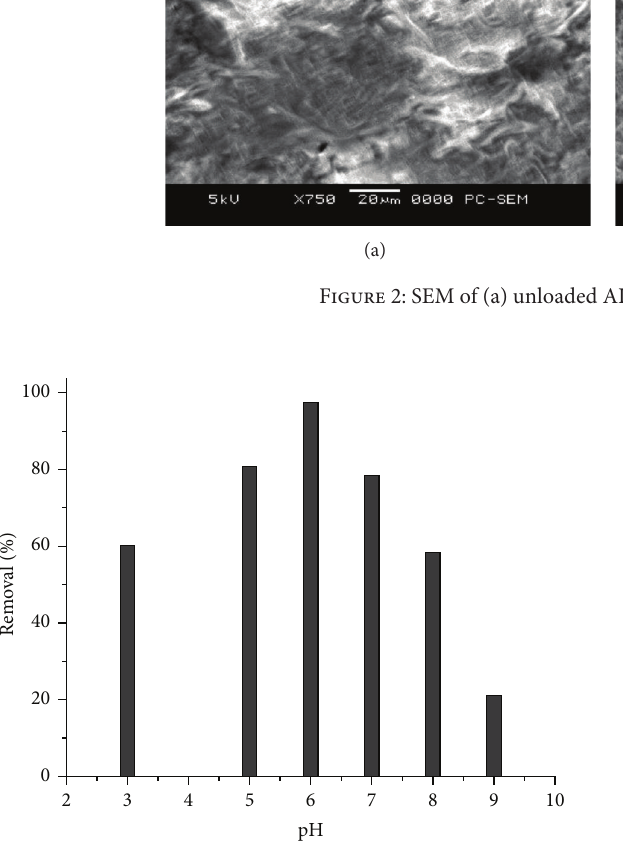
Figure 3: Effect of pH on the Hg(II) removal by ALP biomass.